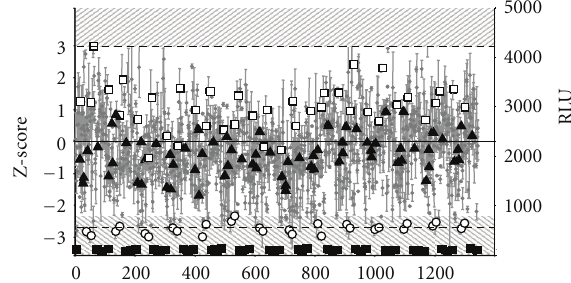
Figure 2: Representation of a typical primary screening run. Fourteen 96-well plates containing siRNAs for the screen and control siRNAs were transfected with RMLuc+I-SceI or pUC in duplicate. Seventy-two hours after transfection, luciferase activity was detected. Each dot represents the mean value per siRNA. The black box shows the luciferase value obtained following transfection with the empty vector (pUC), corresponding to background. Black triangles represent the values obtained for cotransfection with the AS siRNA and RMLuc+I-SceI; white circles represent the values obtained for cotransfection with RAD51 siRNA and RMLuc+I- SceI. Finally, white squares represent the values obtained for cotransfection with LIG4 siRNA and RMLuc+I-SceI. The black line indicates the mean value for the run. Dashed boxes show the cuto ff values for hit